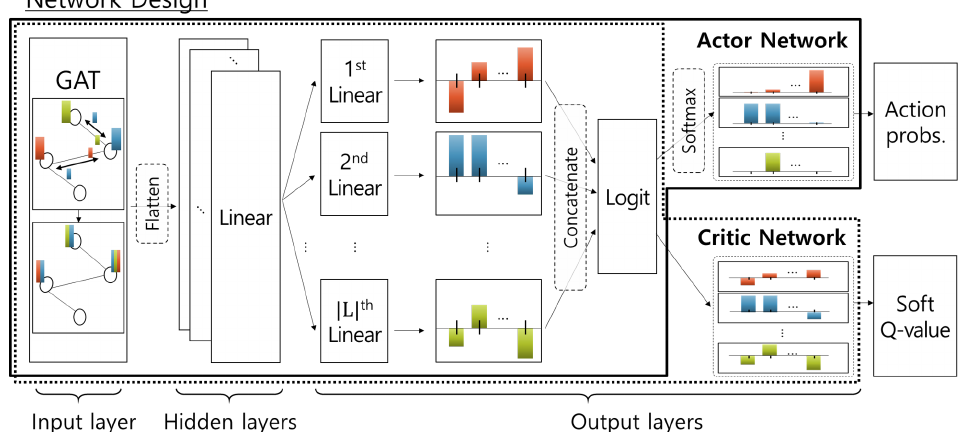
Figure 3. Neural network